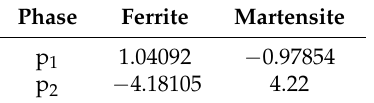
Table 2. Mechanical properties of DP800 steel.